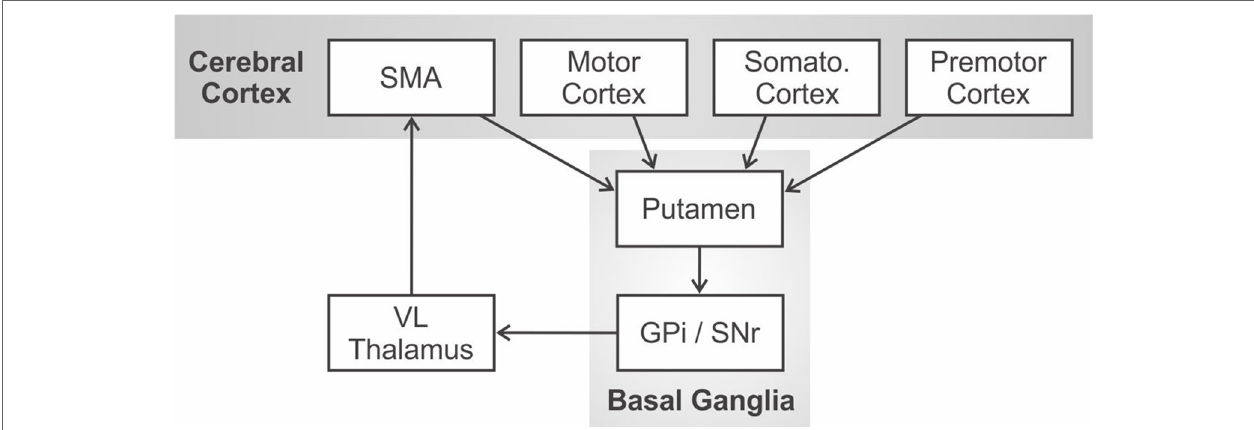
FIGURE 1 | The cortico-basal ganglia motor circuit as originally proposed by Alexander et al. (1986). Abbreviations: GPi = internal segment of the globus pallidus; SMA = supplementary motor area; Somato = somatosensory; SNr = substantia nigra pars reticulata; VL = ventral lateral